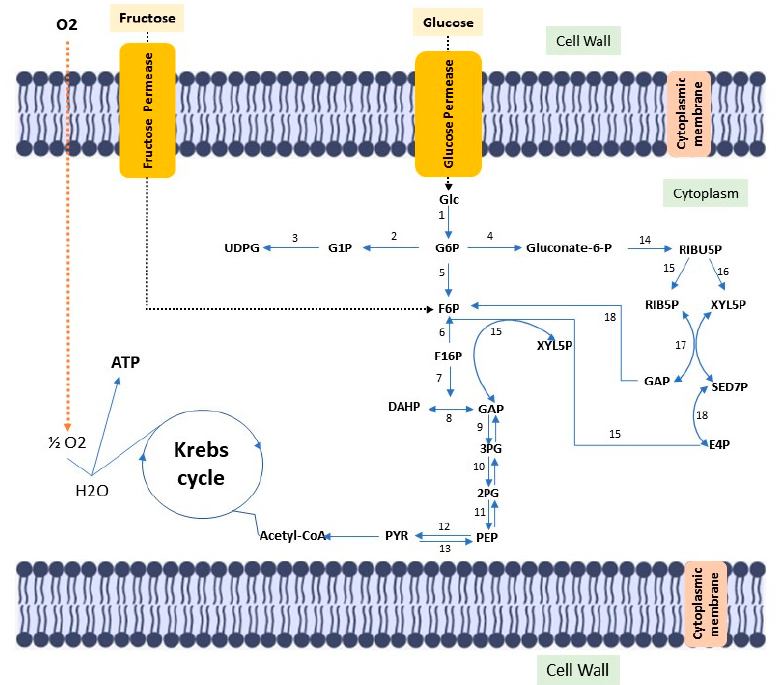
Figure 1. Diagram of the metabolic pathway, stimulated by fructose and glucose, for bacterial cellulose bacterial cellulose biosynthesis. Glc: Glucose; ATP glucokinase (1); GP6: Glucose 6- biosynthesis. Glc: Glucose; ATP glucokinase (1); GP6: Glucose 6-phosphate; Phosphoglucomutase phosphate; Phosphoglucomutase (2); G1P: Glucose 1-phosphate; UTP–glucose-1- phosphate uridylyltransferase (3); UDGP: UDP-glucose; Glucose 6-phosphate dehydrogenase (4); Gluconate-6-p: Gluconate-6-phosphate; Phosphoglycoisomerase (5); F6P: fructose 6-phosphate; Fructokinase ATP (6); F16P: Fructose 1,6-bisphosphate; Aldolase (7); Triose phosphate isomerase (8); DHAP: Dihydroxyacetone phosphate; GAP: glyceraldehyde 3-phosphate; Glyceraldehyde 3-phosphate dehydrogenase (9); 3PG: 3-Phosphoglyceric acid; Phosphoglyceratomutase (10); 2PG: 2-Phosphoglyceric acid; Enolase (11); PEP: 2-phosphoenolpyruvate; Pyruvatokinase (12); Pyruvate diphosphate dikinase (13); PYR: Pyruvate; 6-phosphogluconate dehydrogenase (14); RIBU5P: Ribulose 5-phosphate; Phosphorribulose epimerase (15); Phosphorribulose isomerase (16); RIB5P: Ribose 5-phosphate; XYL5P: Xylulose 5-phosphate; Transacetolase (17); SED7P: sedoheptulose 7-phosphate; E4P: Erythrose 4-phosphate; GAP: glyceraldehyde 3-phosphate; Transaldolase (18).